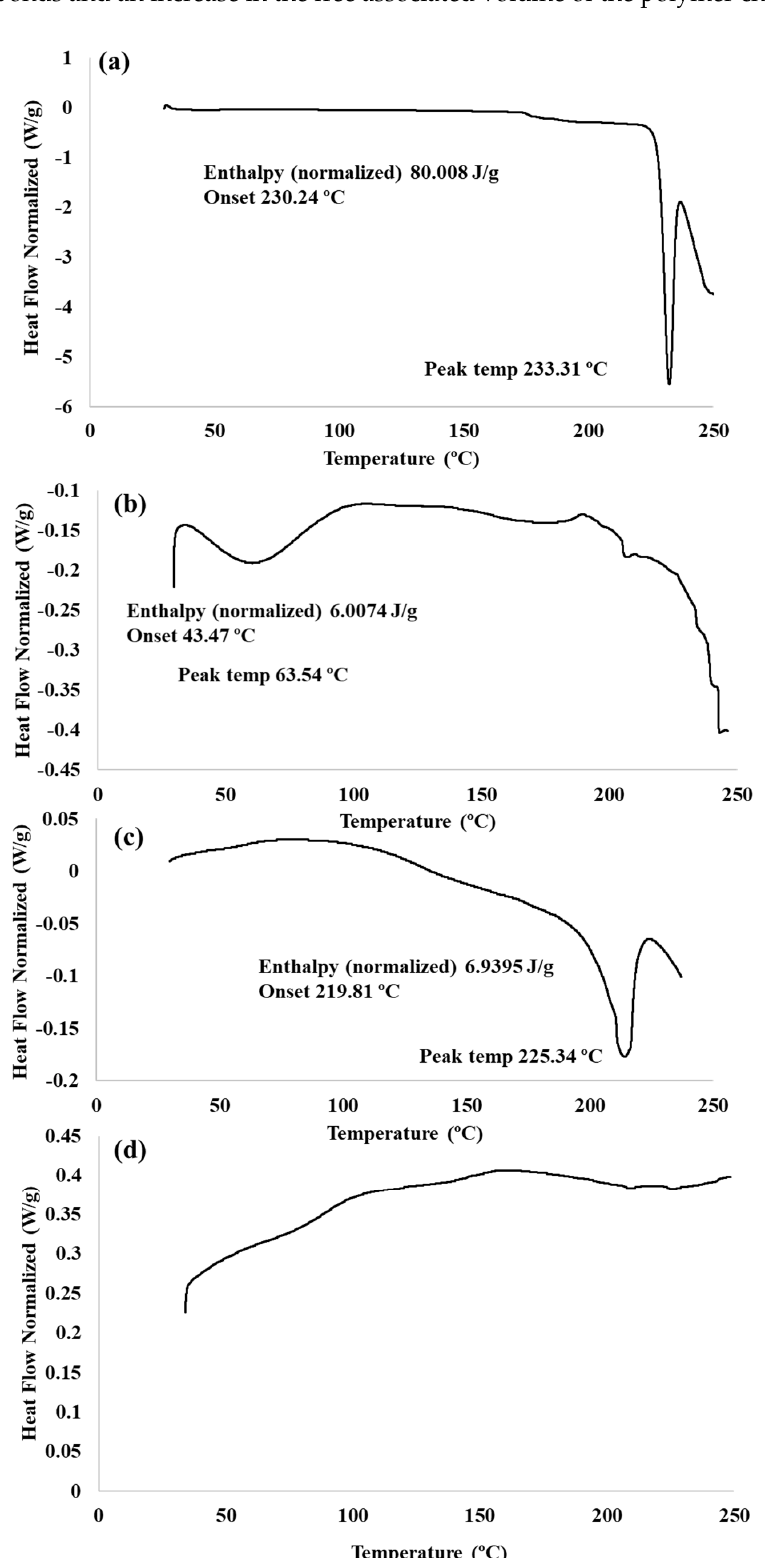
Figure 5. DSC curves for ( a ) PMZ, ( b ) Arg-PA, ( c ) the PMZ-Arg-PA physical mixture, and ( d ) PMZ/Arg-PA NCs.